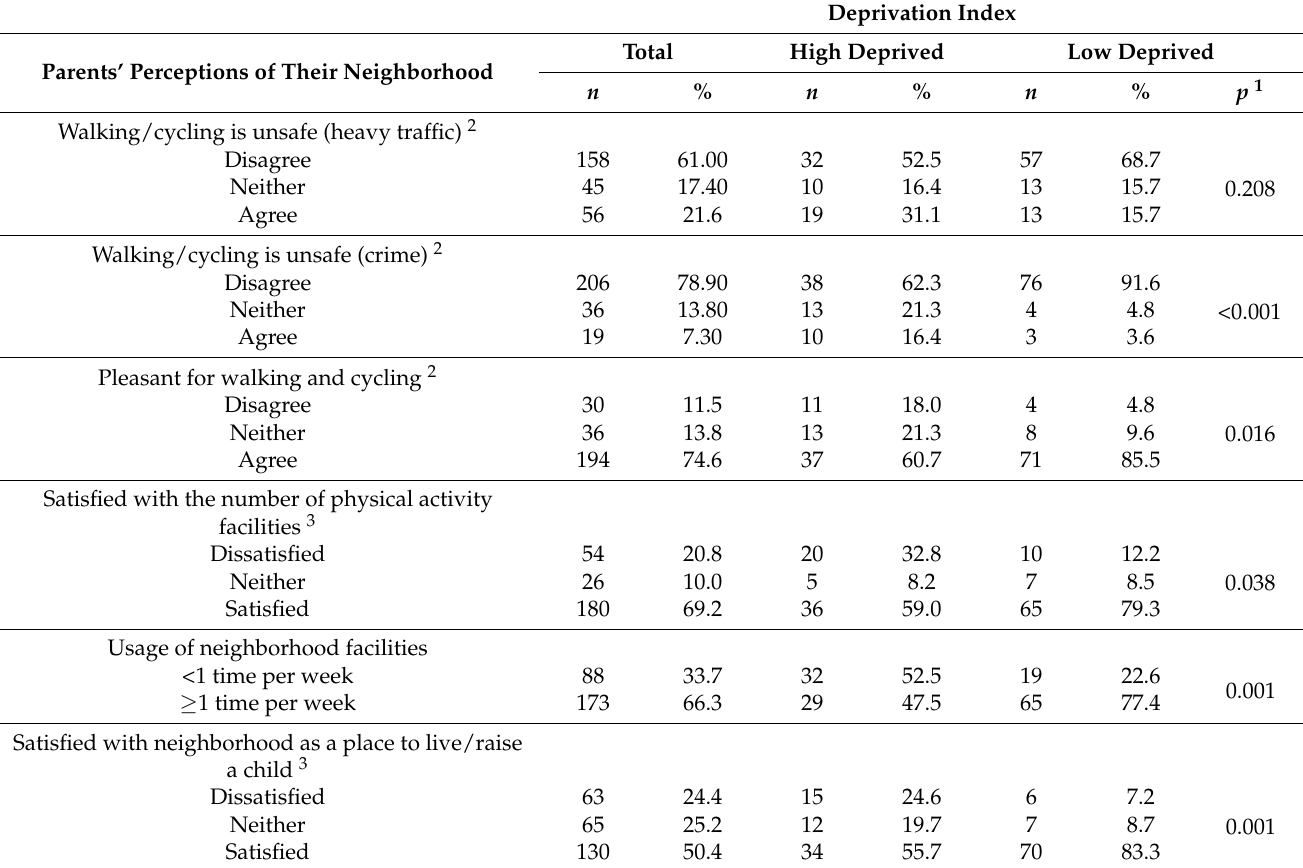
Table 2. Parents’ perceptions of their neighborhoods by neighborhood deprivation